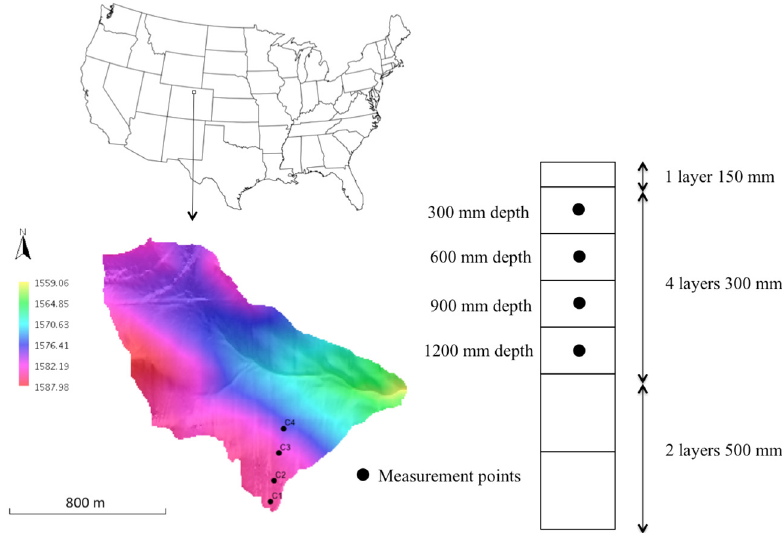
Figure 4. Drake watershed digital elevation model and measurement stations. The soil profile shows model layers and depths of automated SM measurements. Sensors are centered on the depths shown, with measured intervals of approximately 100 mm each ([33,37]).